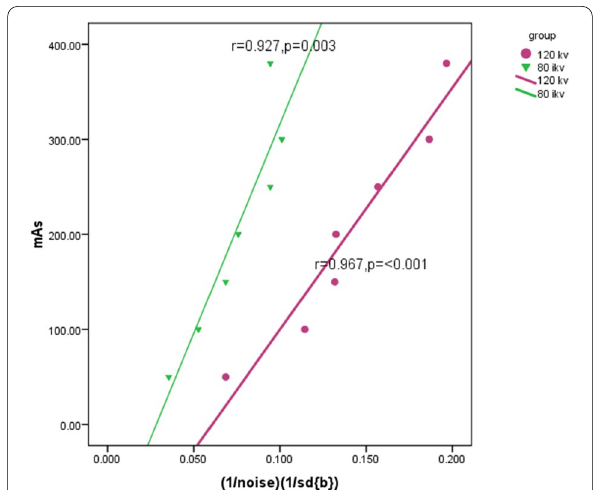
Fig. 3 Scatter diagram for positive correlation between (1/noise) and mAs. At same mAs, image noise acquired with 120 KVP is less than image noise acquired with 80 KVP